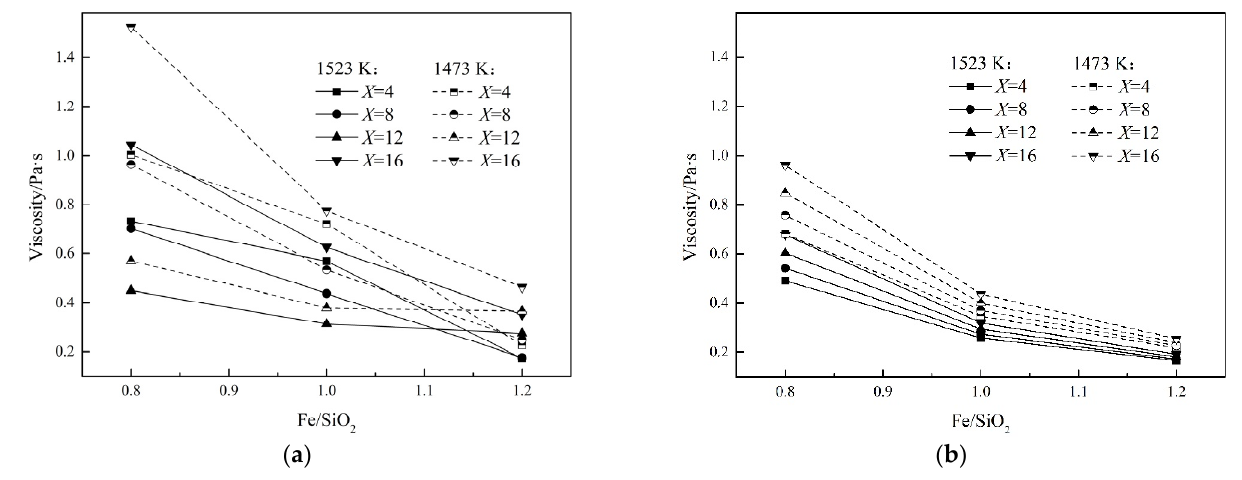
Figure 6. Effect of Fe/SiO 2 on the viscosity of the FeO − X wt%Fe 2 O 3 − SiO 2 − 8 wt% CaO − 3 wt%MgO − 3 wt%Al 2 O 3 slag system at fixed temperatures with different Fe 2 O 3 content: ( a ) results of experimental tests; ( b ) results of simulation tests by Factsage 7.3.